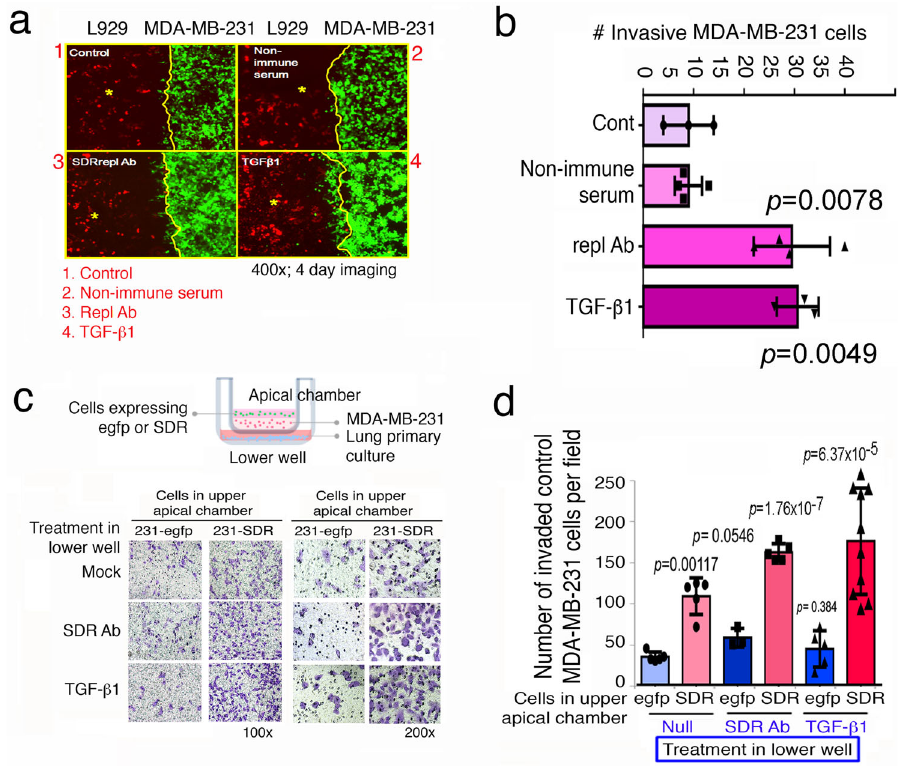
Fig. 9 TGF- β 1 utilize membrane T β RII and SDR domain of WWOX to regulate cell invasion. a , b Stable transfectants of MDA-MB-231-EGFP and L929- DsRed2 were established. These cells were seeded in either side of the chambers of the culture-insert (ibidi), respectively. After overnight culture, the insert was gently removed. The cells were cultured at 37 °C with 5% CO 2 for 4 days. Image J software was used to count MDA-MB-231 cells invading